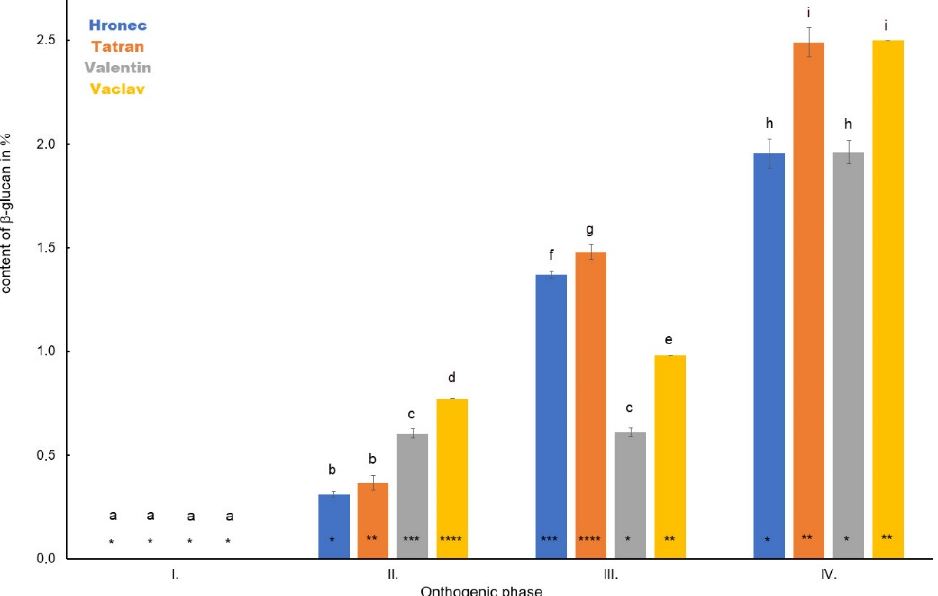
Figure 4. The dynamics in the content of β‐ D ‐ glucan in panicles of four analysed oat varieties during plant development. Different letters indicate a statistically significant difference between individual varieties in specific ontogenetic phase evaluated by ANOVA (LSD, p ≤ 0.05). Star symbols (*, **, ***, and ****) represent statistically significant difference between four varieties evaluated for each monitored ontogenetic phase individually by ANOVA (LSD, p ≤ 0.05).